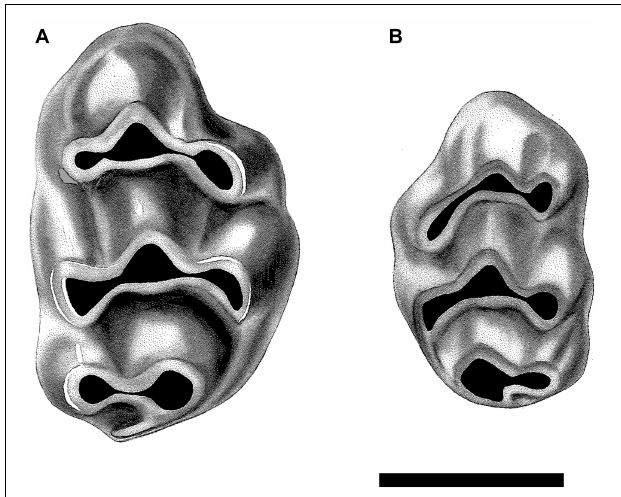
FIGURE 4 | Upper first molars of the dominant murines present at locality Y182, 9.2 Ma. (A) Right M1 of Karnimata darwini , specimen YGSP 7720, and (B) smaller left M1 of Progonomys debruijni , YGSP 7736. Both at same 1 mm scale, anterior is upward.